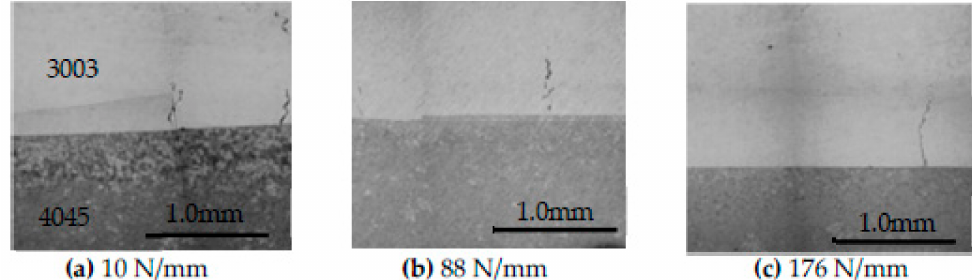
Figure 9. Cross-section near interface of as-cast clad strip cast at different roll loads. Roll load: ( a ) 10 N/mm, ( b ) 88 N/mm, ( c ) 176